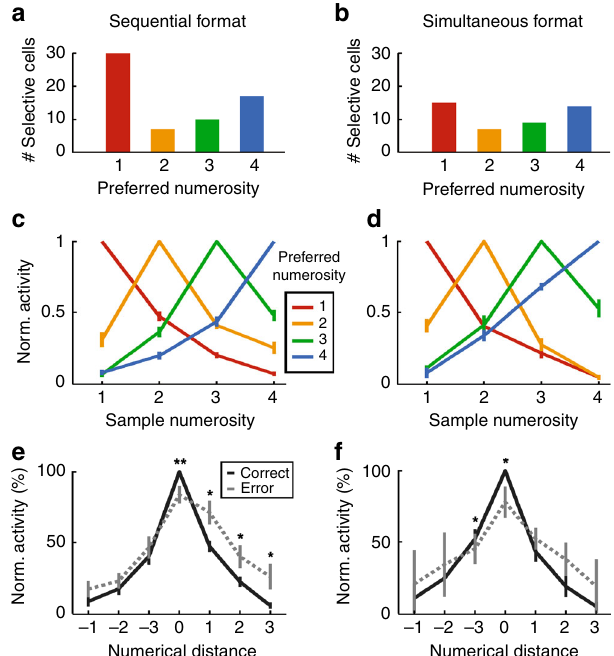
Fig. 3 Tuning to numerosity during the sample period. a , b Distribution of neurons that preferred each of the presented numerosities in both formats. c , d Normalized responses averaged over all neurons preferring the same numerosity. Tuning functions display peak response to preferred numerosities with a decrease for more distant numerosities. e , f Average tuning curves for correct compared to error trials. Neuronal responses in error trials are deteriorated, suggesting behavioral relevance * p <